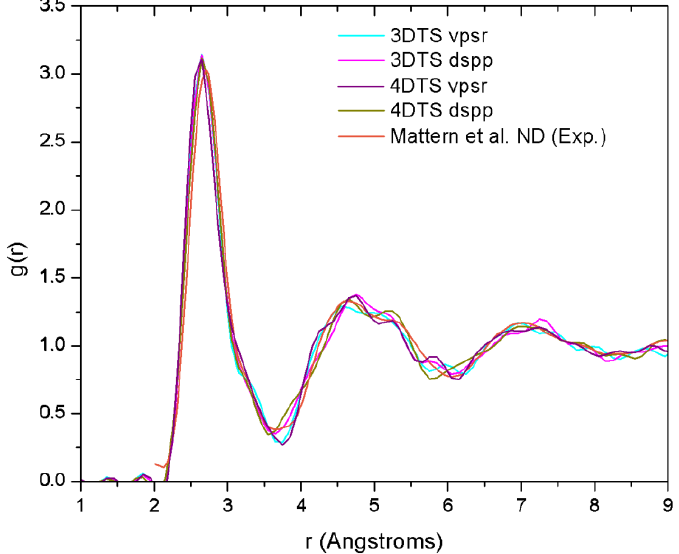
Figure 31. Comparison of our RDFs and the experimental glassy RDF of Mattern et al . [30]. Our results were weighted for neutron scattering in order to compare them with